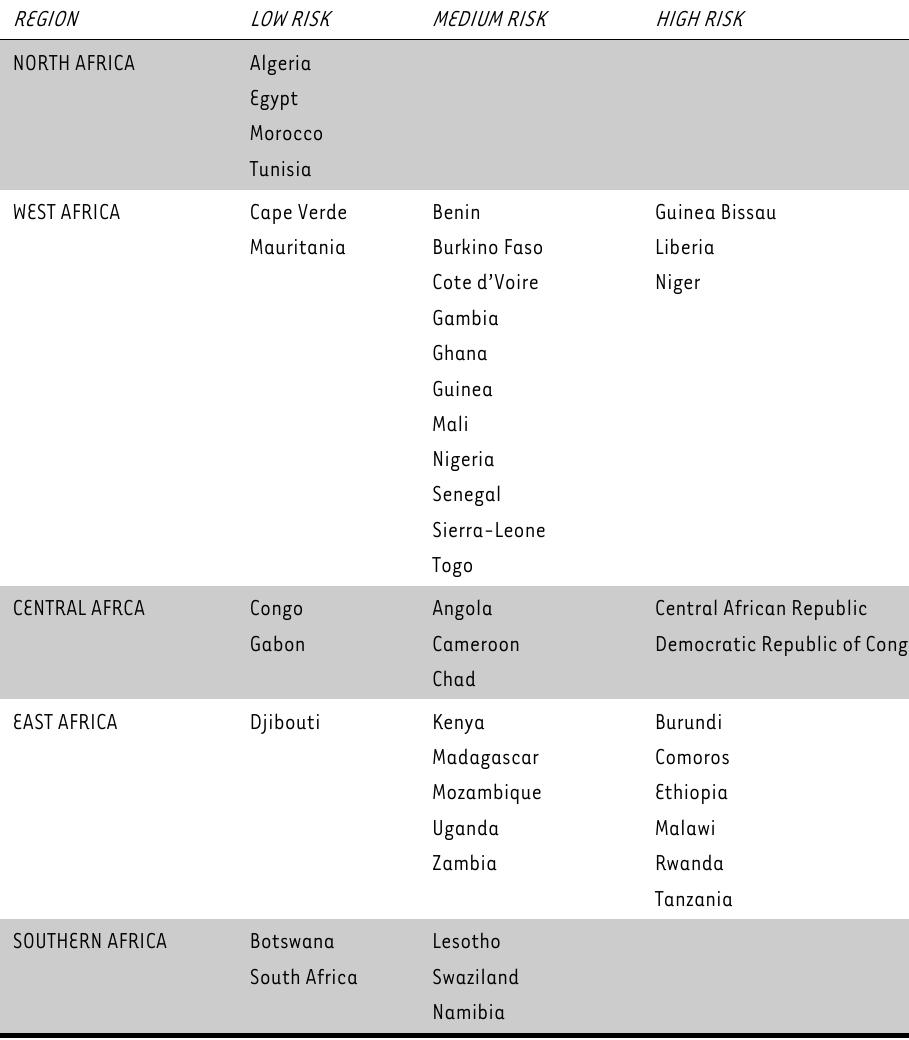
TABLE 2: Risk profile of countries by region